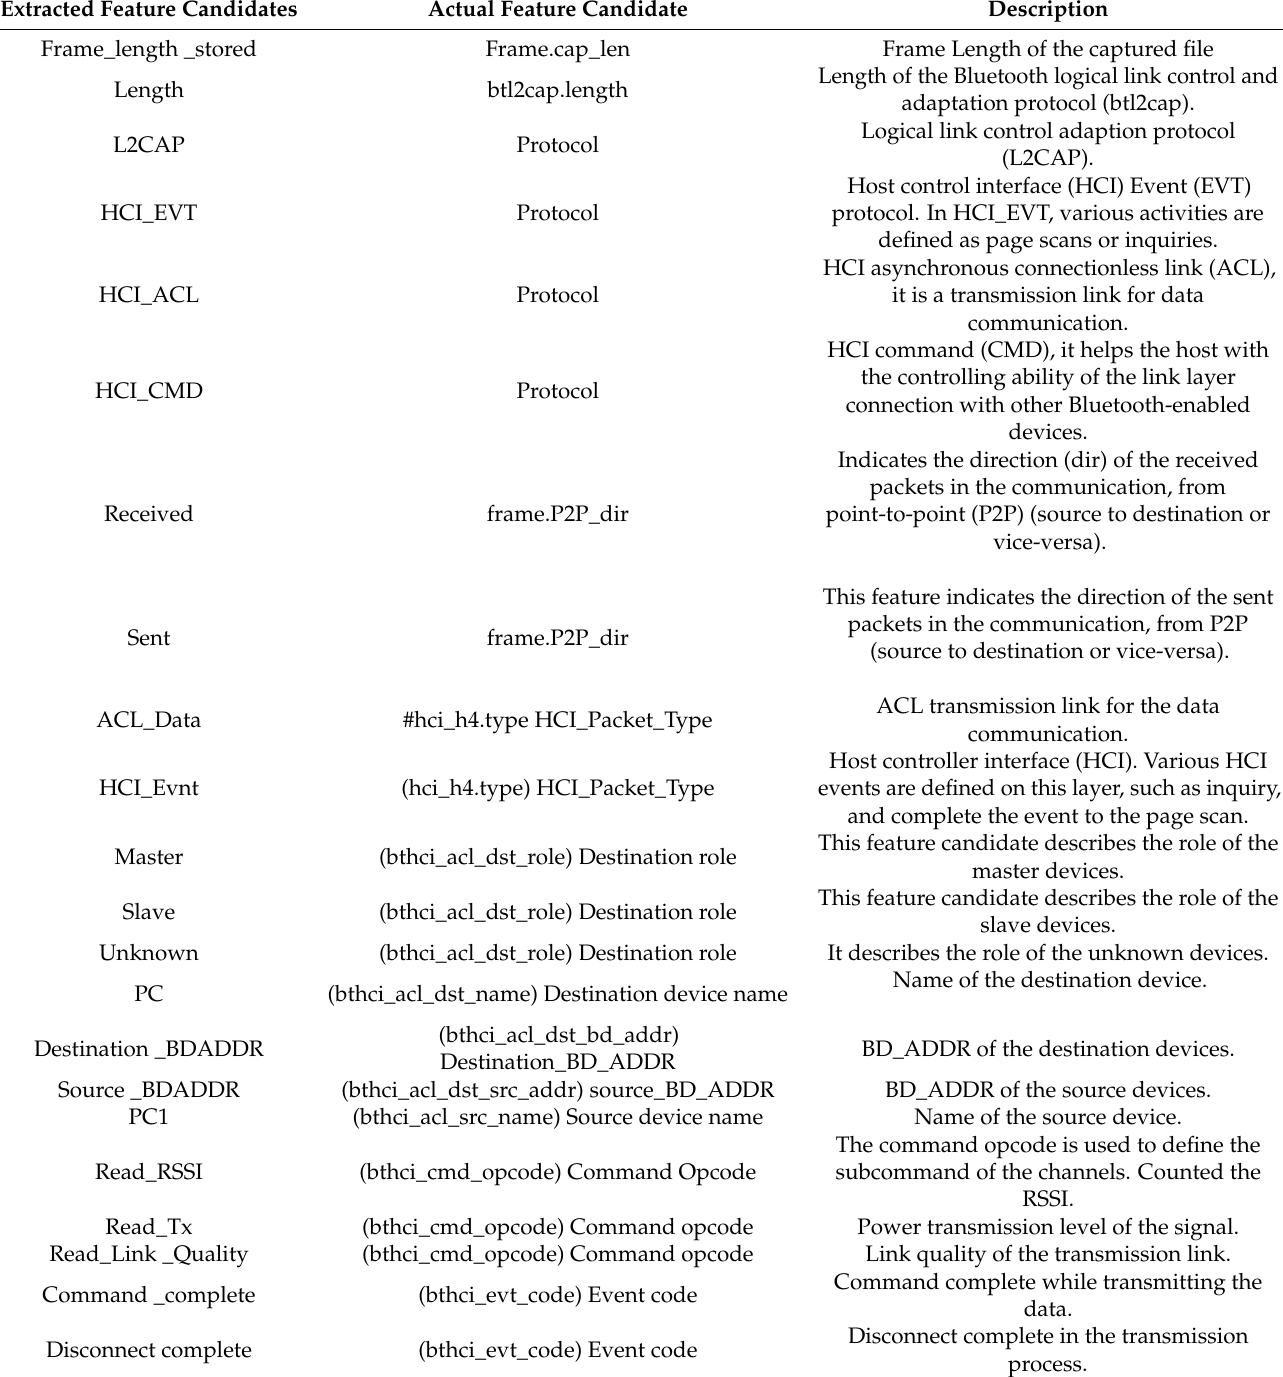
Table A2. Features candidates for the proposed